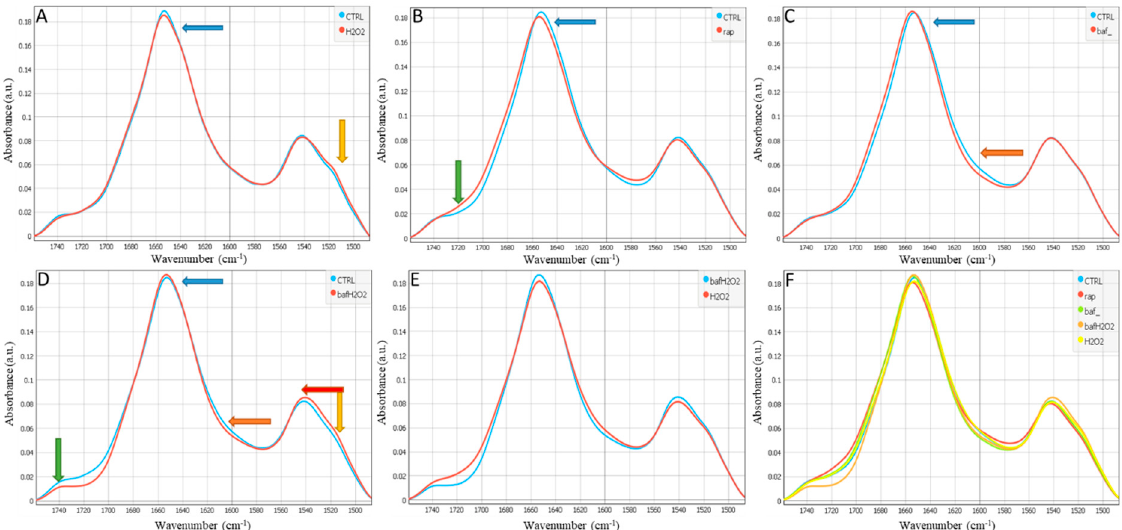
Figure 1. Average spectra of the protein and ester region (1485–1760 cm -1 ) in hRPE cells: ( A ) Control (untreated) vs. H 2 O 2, ( B ) Control vs. Rap, ( C ) Control vs. Baf, ( D ) Control vs. Baf+H 2 O 2 , ( E ) Baf+H 2 O 2 vs. H 2 O 2 , and ( F ) all conditions are being shown. Representative data of a number of cells per condition (N = 35–37 cells).